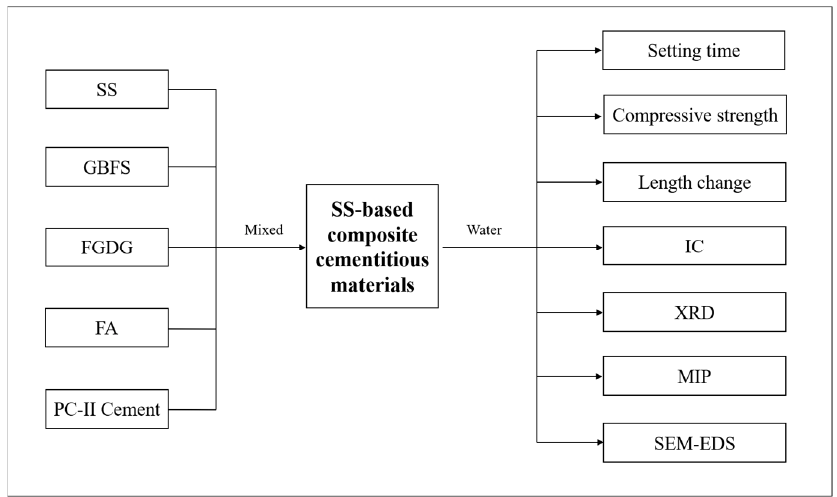
Figure 3. Experimental fl owchart of this study.